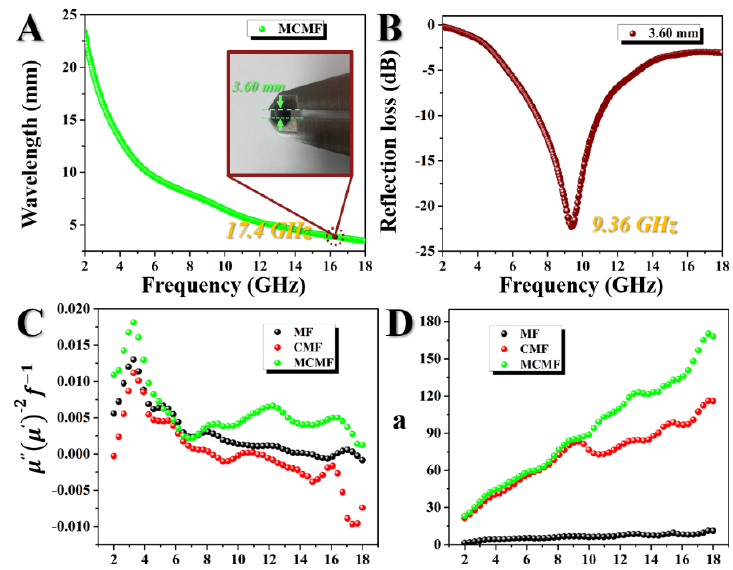
Figure 9. ( A ) Frequency dependence of microwave transmission in MCMF. The inset shows a photograph of the thickness for MCMF/paraffin composites using a Vernier caliper. ( B ) Reflection loss value of MCMF at 3.24 mm. The ( C ) C 0 and ( D ) α values of the three absorbers.